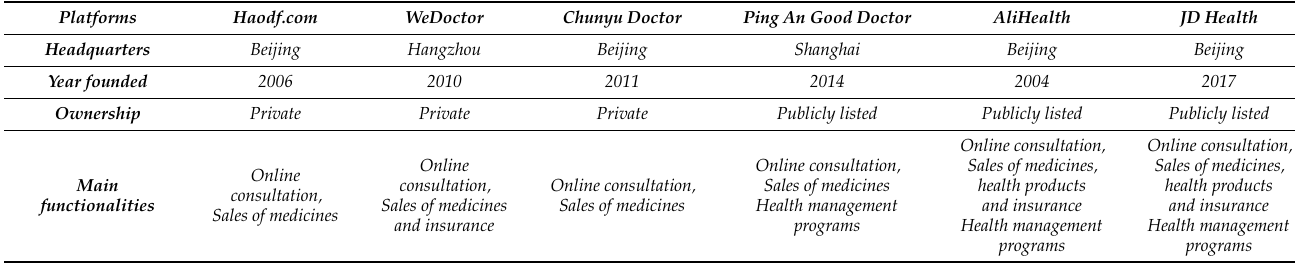
Table 1. Profiles of key m-Health platforms for online